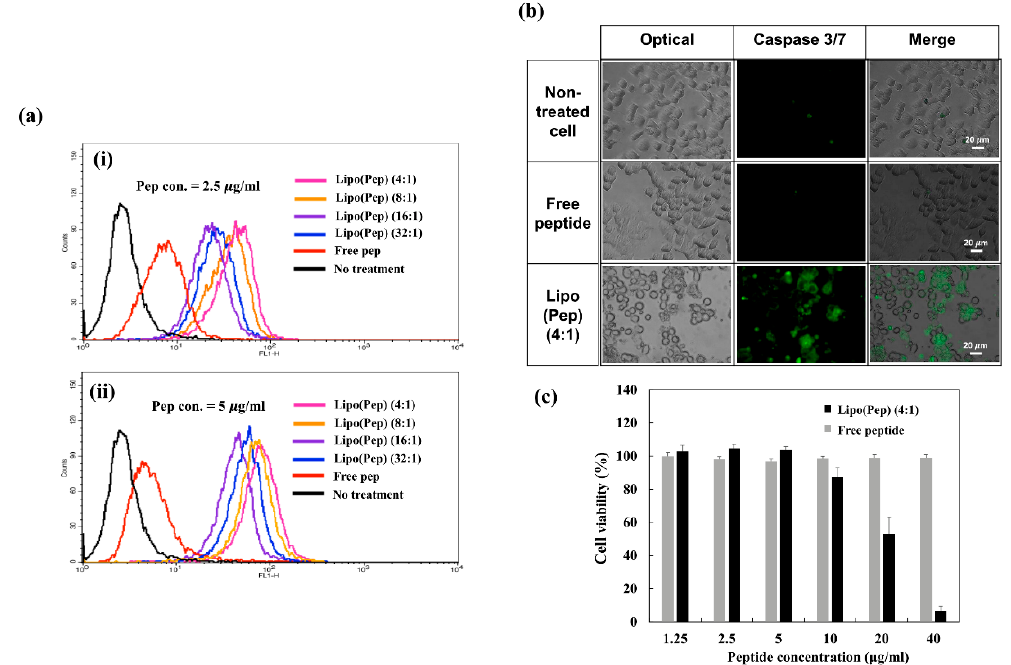
Figure 3. In vitro characterization of free peptide and Lipo (Pep); ( a ) quantification of cellular uptake of FITC-labeled peptide in KB cells at different peptide concentration; ( b ) effect of peptide on caspase 3/7 activity in KB cells; ( c ) cell viability of KB cells treated with Lipo (Pep) or free peptide.